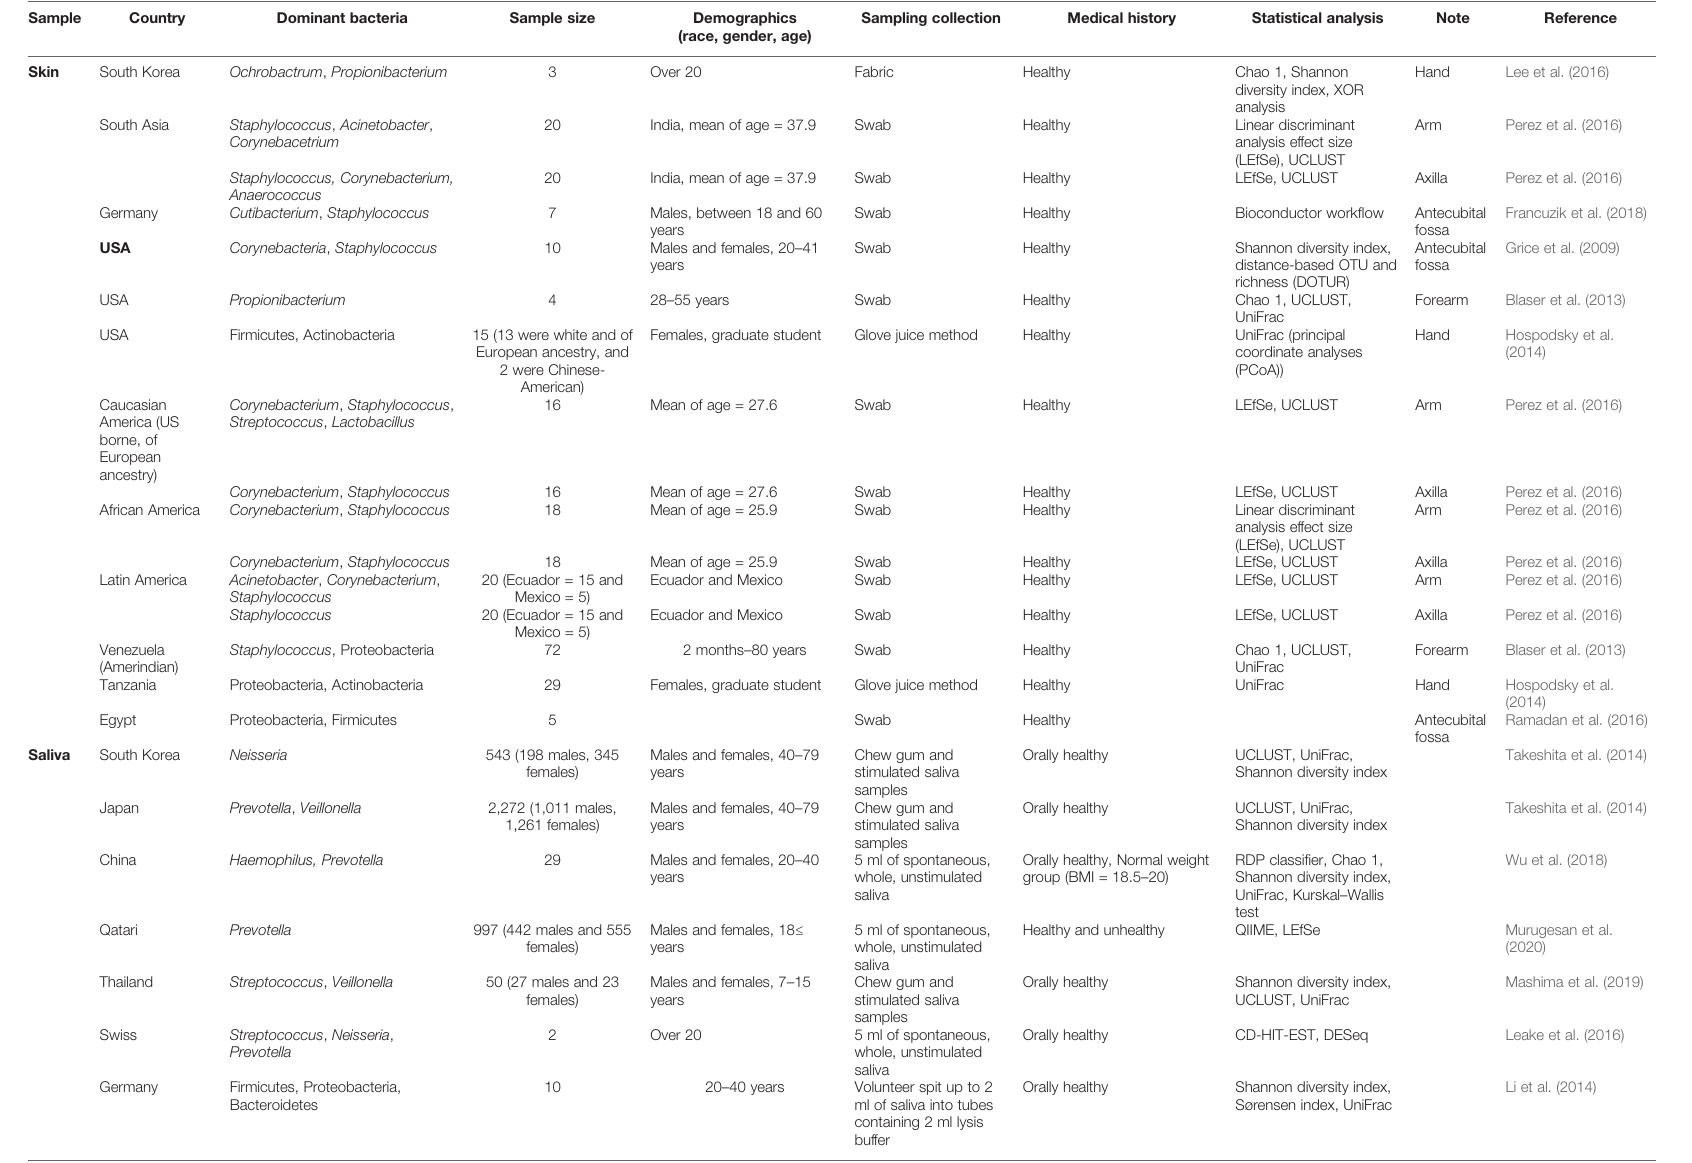
TABLE 2 | Summary of country in non-FMD studies assessing microbial composition of the skin, saliva, vaginal fl uid, and stool.